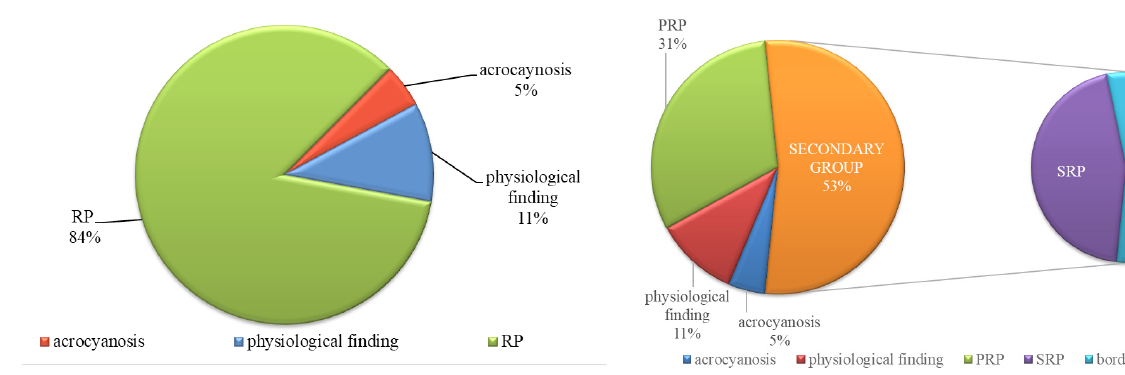
Fig. 3. Incidence of the most common diseases in the observed patient population.